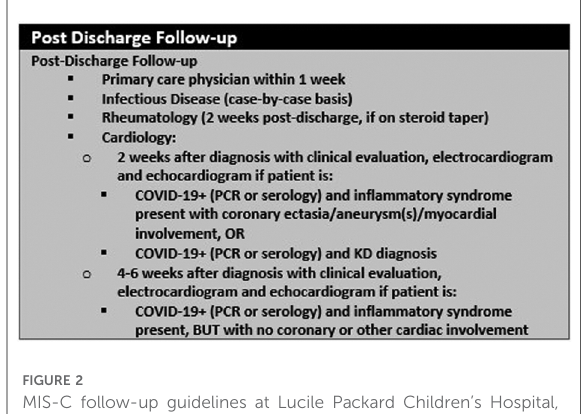
FIGURE 2 MIS-C follow-up guidelines at Lucile Packard Children ’ s Hospital, Stanford University